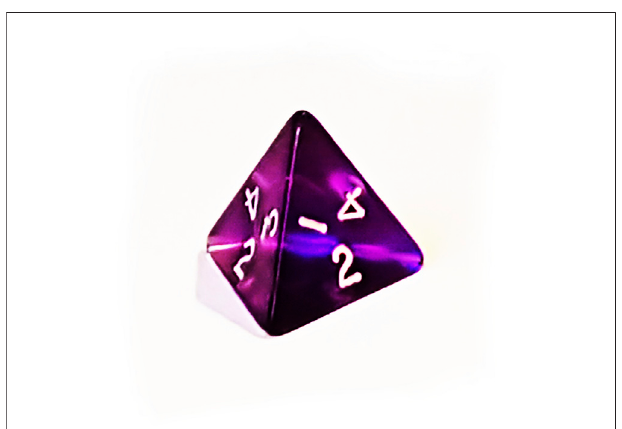
FIGURE1| Afour-sideddie.Incontrasttosix-sideddicetheoutcomeof arollisdeterminedbythenumberofthefaceonthebottom.Thecon fi guration shown in the picture corresponds to an outcome of